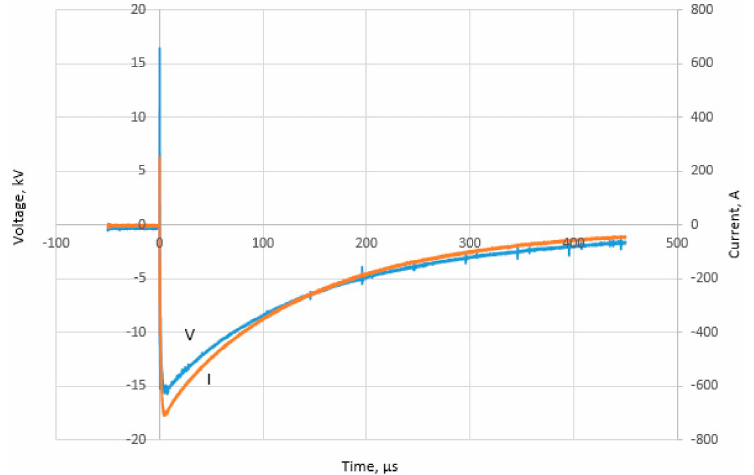
Figure 15. Voltage and current traces of negative polarity for electrodes installed at site 2, at a charging voltage of 30 kV.